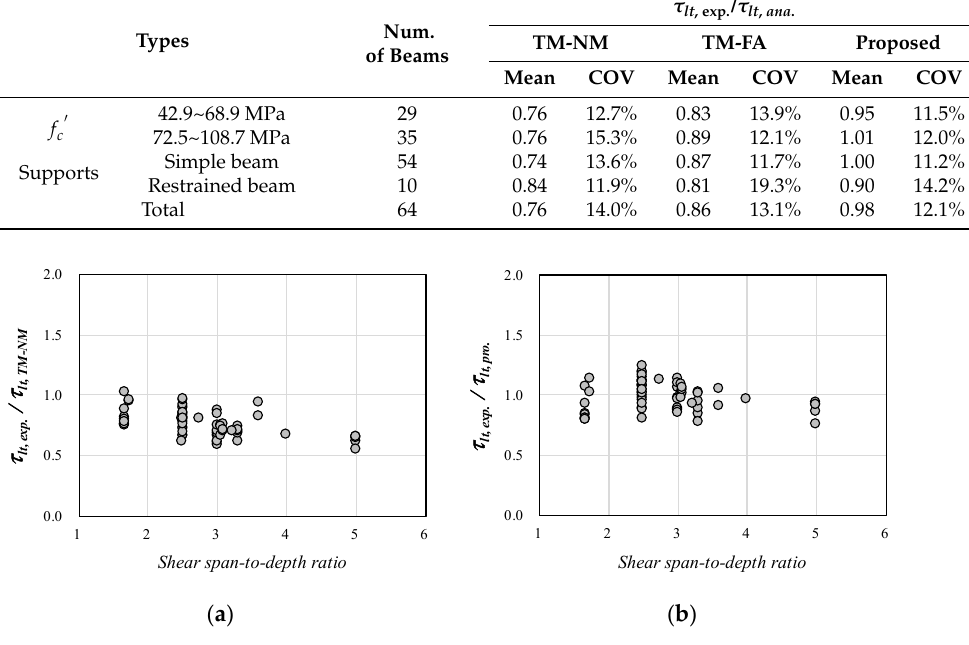
Figure 8. Prediction results of analytical models on a/d : ( a ) TM-NM; ( b ) proposed model . As shown in Table 2, the TM-FA with the angle β fixed to zero greatly overesti-